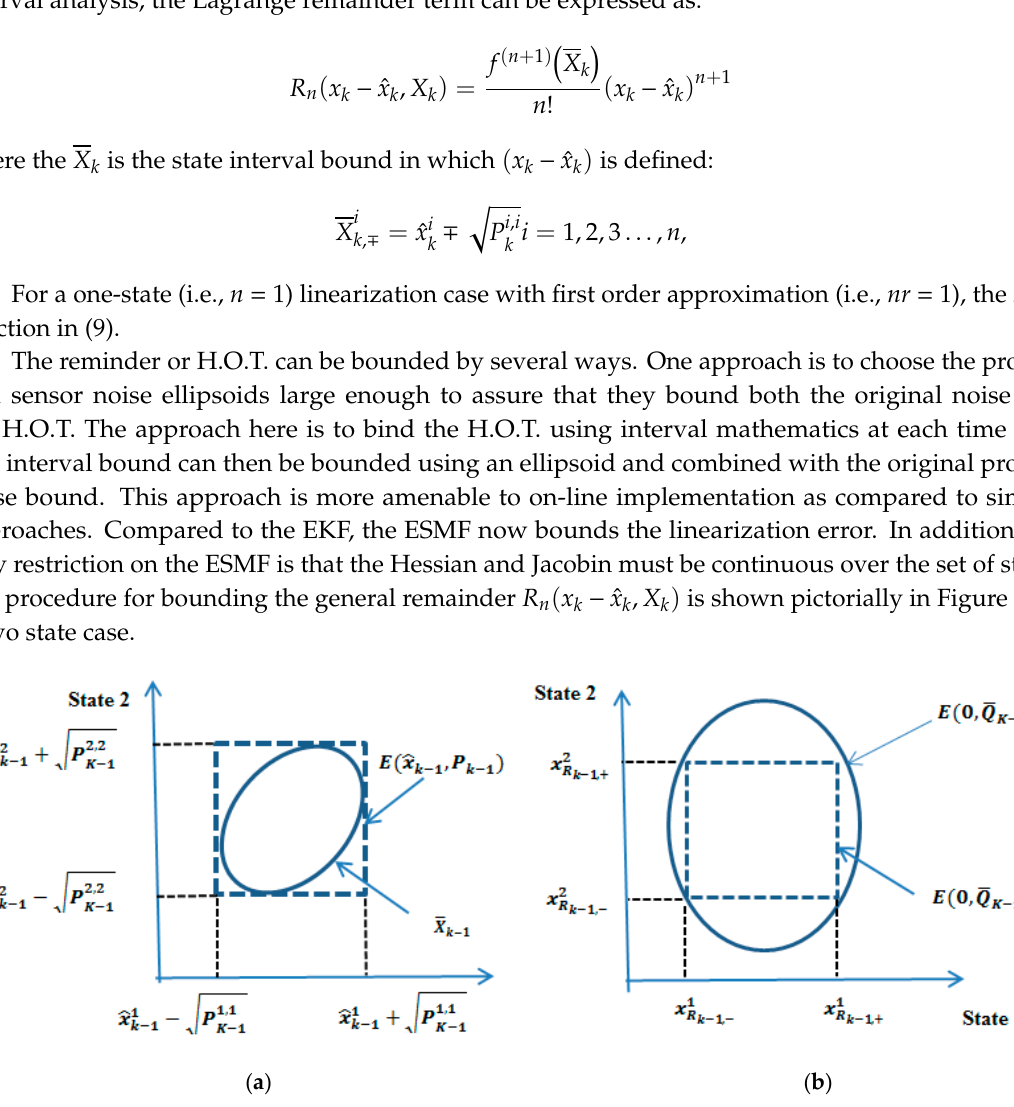
Figure 3. ( a ) Derivation of the interval X_k from P_((K,k)); ( b ) derivation of the bound on the study (illustration of ellipsoidal bound of linearization error)